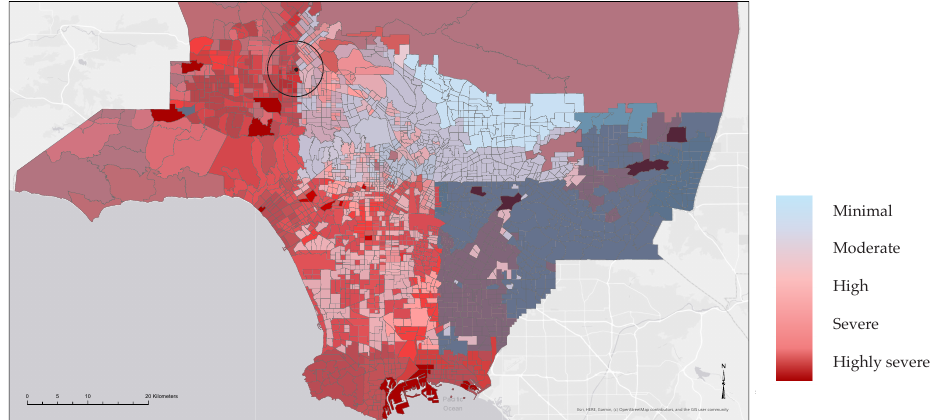
Figure 9. Los Angeles’ vulnerability map. Panorama City neighbourhood appears in the middle of the black